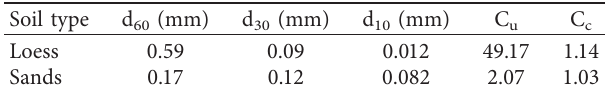
Table 2: The coefficients of uniformity (C the tested